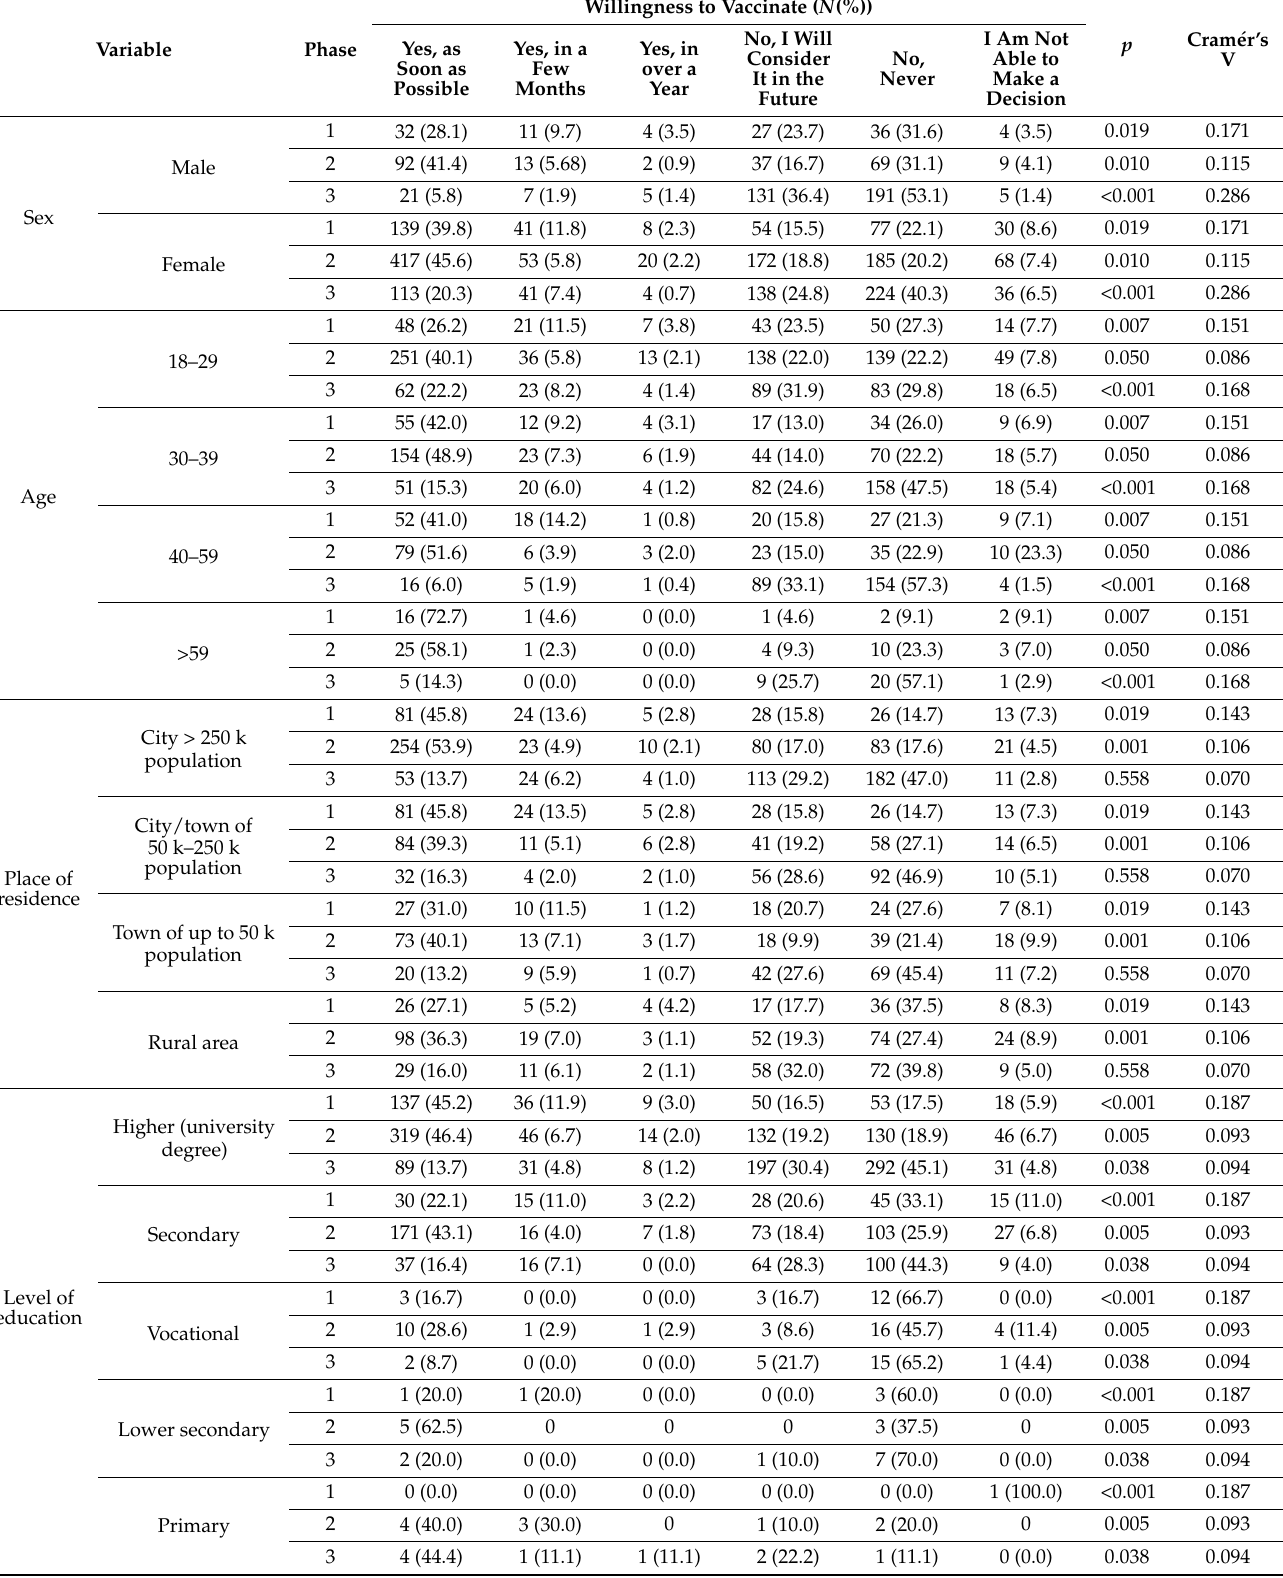
Table 5. Impact of sociodemographic variables on attitudes towards COVID-19